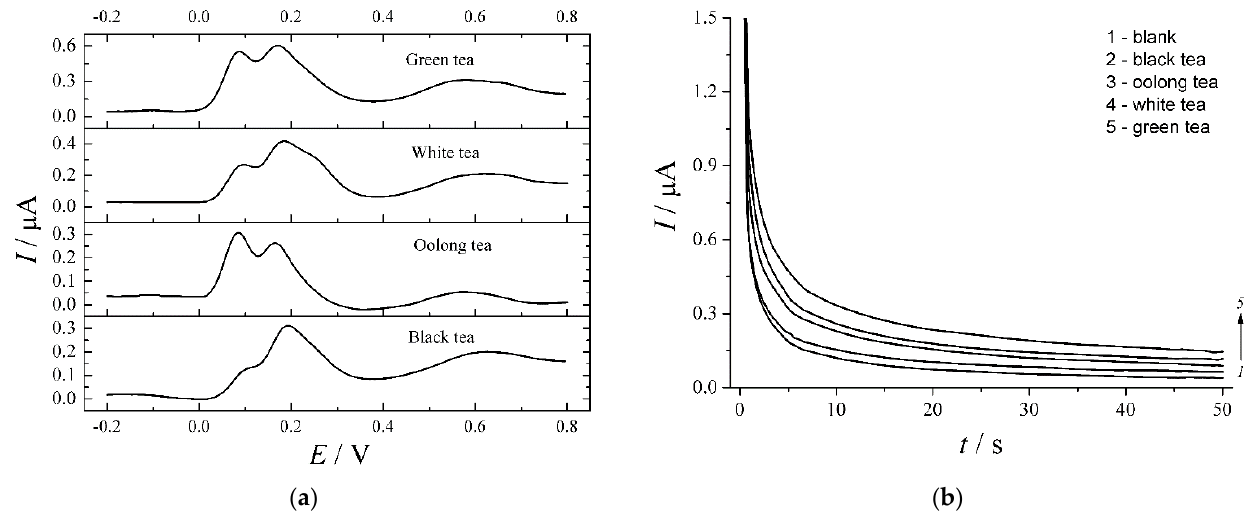
Figure 13. Typical baseline-corrected differential pulse voltammograms ( a ) and chronoamperograms ( b ) of tea on polyquercetin/MWCNTs/GCE in phosphate buffer pH 7.0. Reproduced with modification from [78] with permission from Springer Nature.